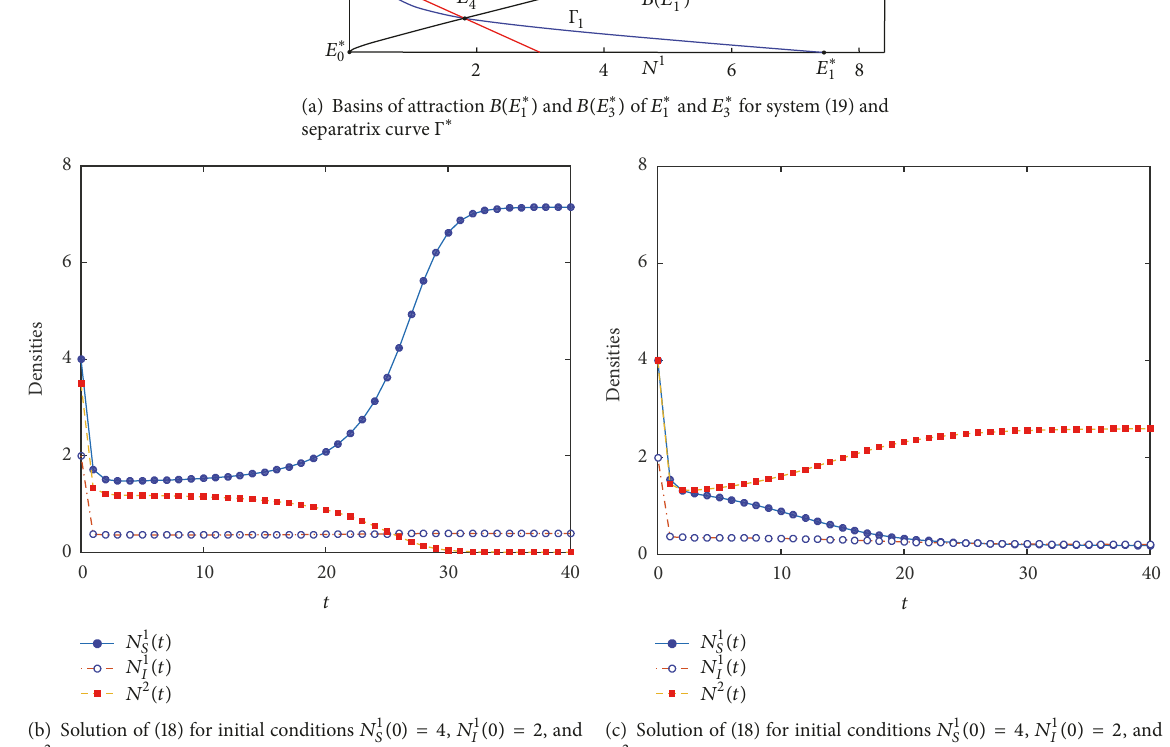
Figure 2: Basins of attraction 𝐵(𝐸 ∗ 1 ) and 𝐵(𝐸 ∗ 3 ) of 𝐸 ∗ 1 and 𝐸 ∗ 3 for the aggregated system (19) and solutions versus time for the original system (18). The parameter values are 𝑘 = 20 , 𝛾 = 0.9 , 𝛽 = 1.125 , 𝑏 1 𝑆 = 10 , 𝑏 1 𝐼 = 20 , 𝑏 2 = 4 , 𝑐 𝑆𝑆 = 0.75 , 𝑐 𝑆𝐼 = 2 , 𝑐 𝐼𝑆 = 9 , 𝑐 𝐼𝐼 = 14 , 𝑐 𝑆2 = 6 , 𝑐 𝐼2 = 1 , 𝑐 = 0.5 , 𝑐 = 3 , and 𝑐 = 1 , which correspond to case 𝐶 2𝑆 2𝐼 22 1𝑏 .